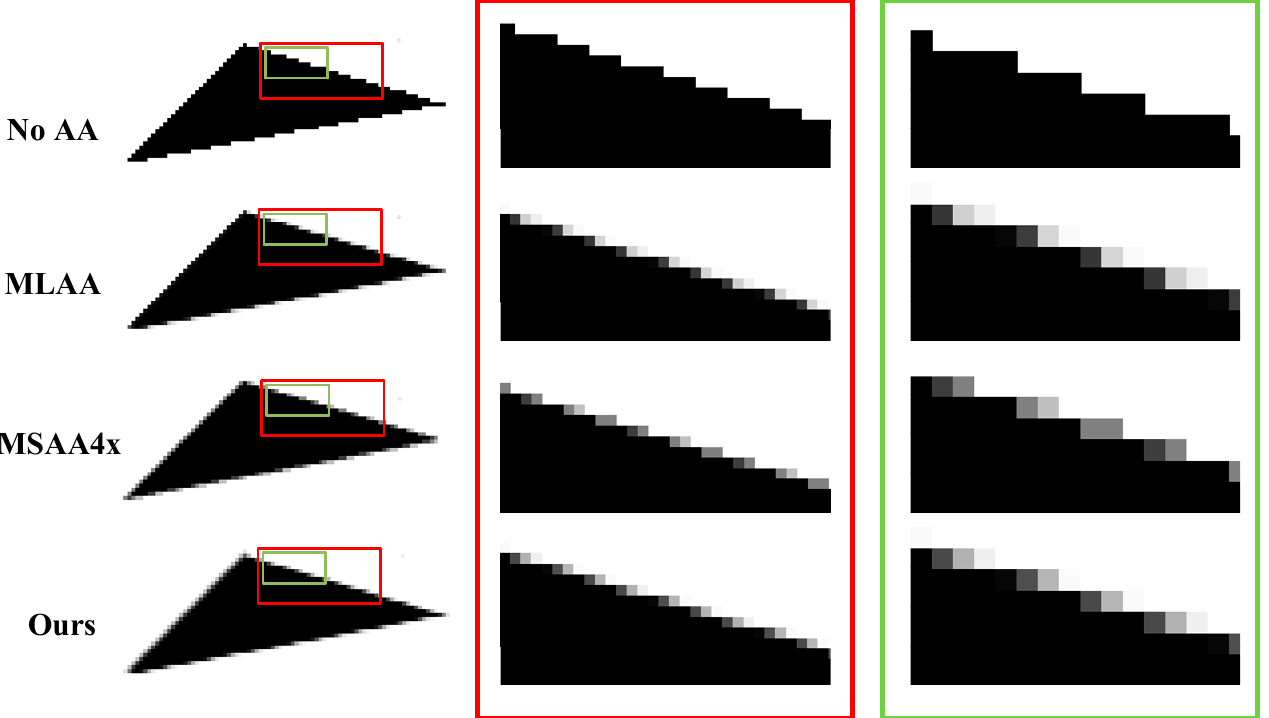
Figure 13. Anti-aliasing performance achieved by our algorithm and other algorithms.